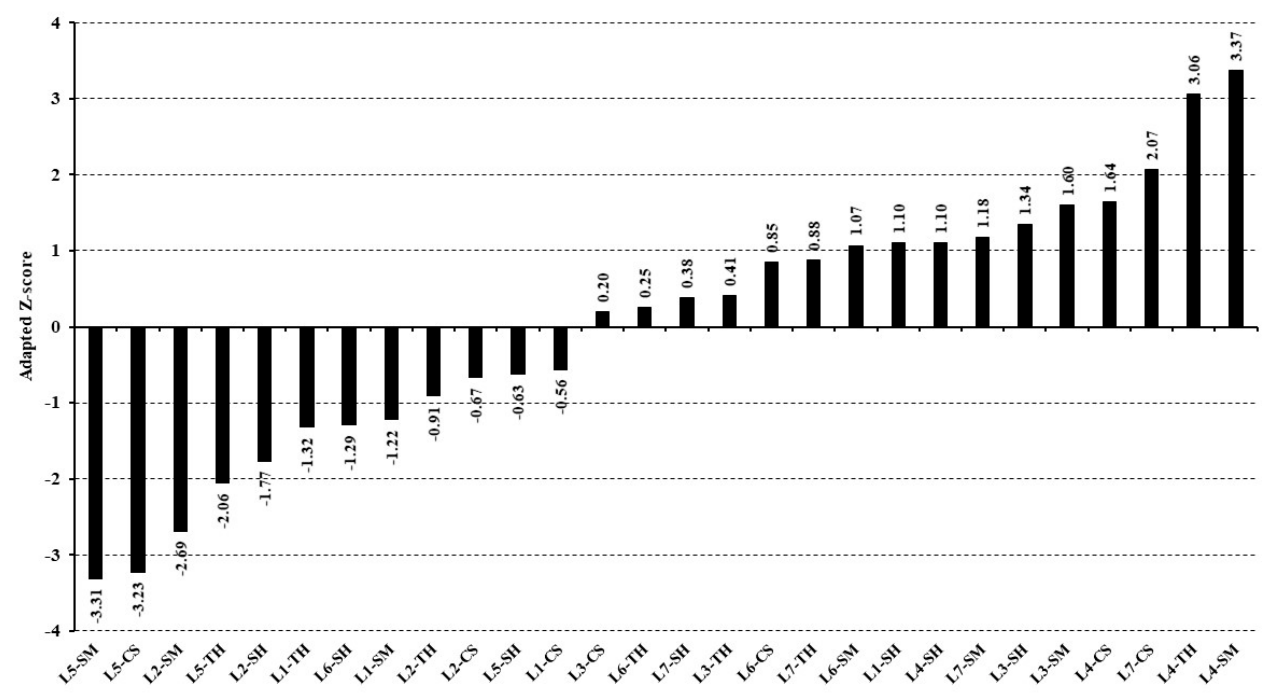
Figure 6. Adapted Z-scores for in vitro dry matter digestibility expressed according to different laboratories (L1–L7) and feeds (TH, Tifton 85 hay; CS, corn silage; SM, soybean meal; and SH, soybean hulls). For details, see Equation (14).